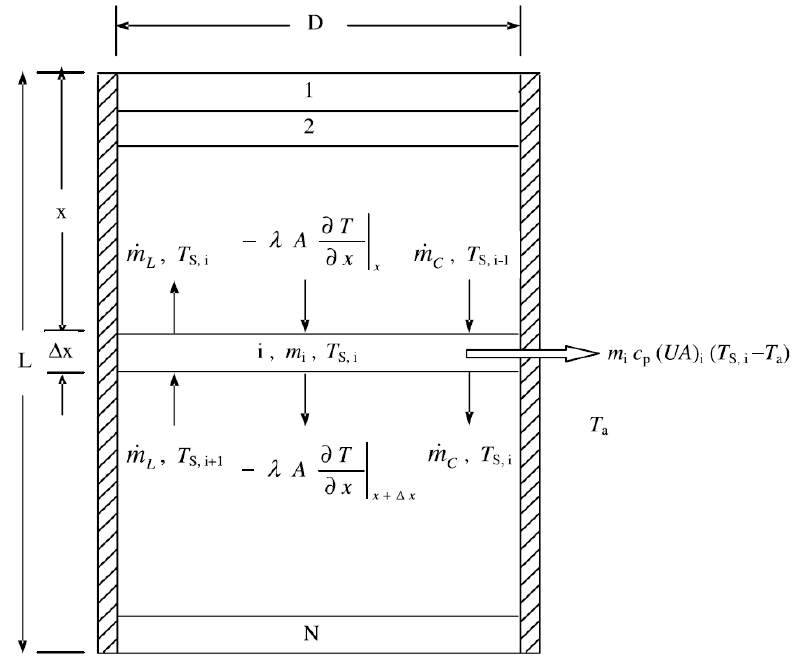
Figure 9. Schematic of stratified themocline TES. (Reprinted from [90] with permission of